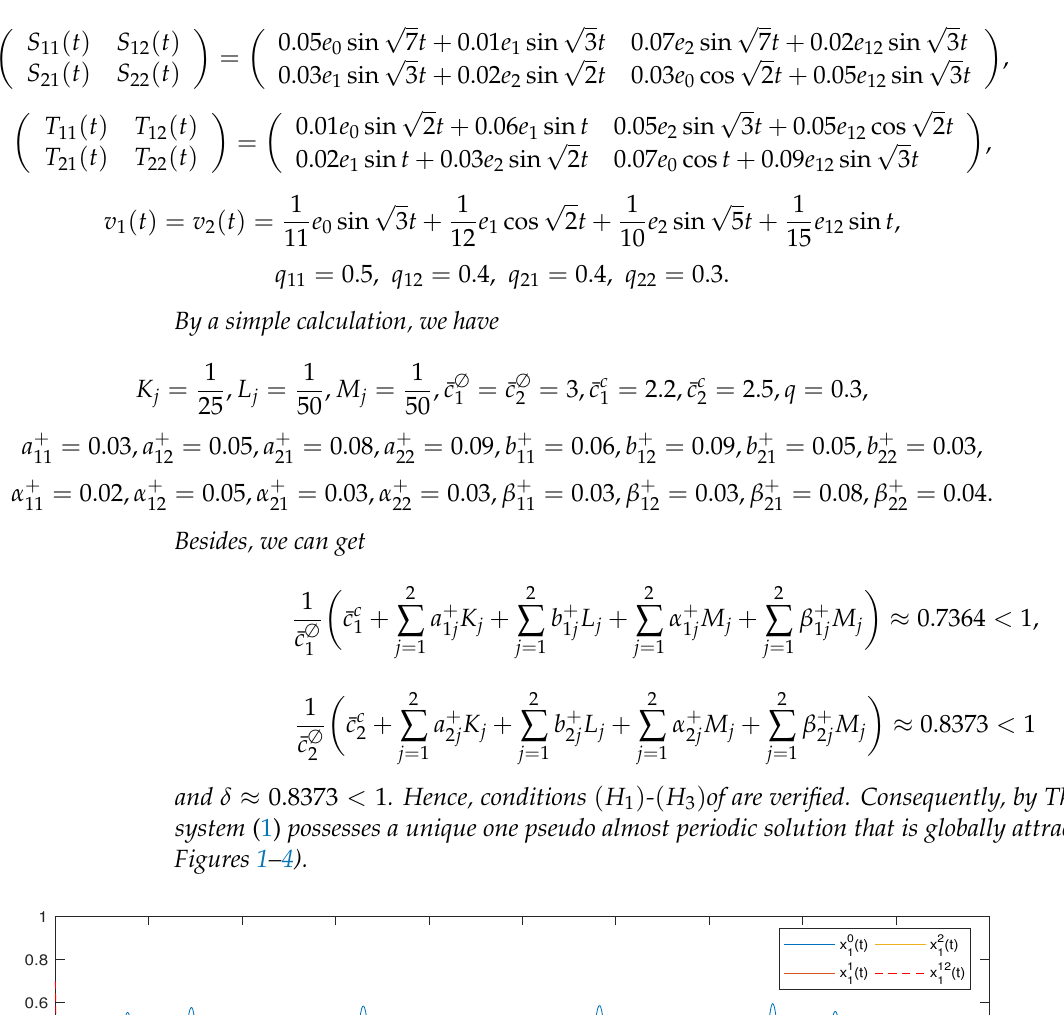
, x 1 , x 2 , x 12 of (1) with different initial 1 1 1 1